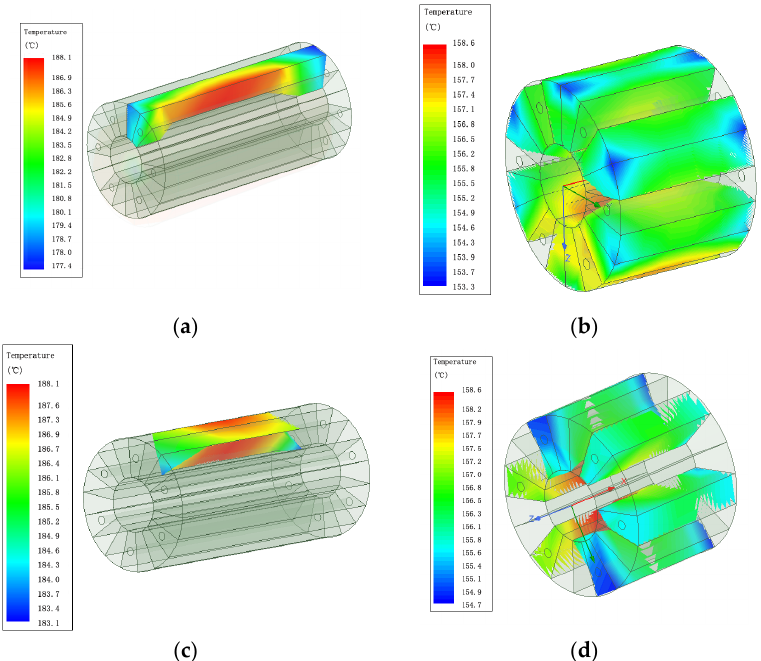
Figure 12. Heat distributions inside model 1 and model 2. ( a ) NdFeB magnets of model 1; ( b ) NdFeB magnets of model 2; ( c ) Fe 49 Co 49 V 2 of model 1; ( d ) Fe 49 Co 49 V 2 of model 2.